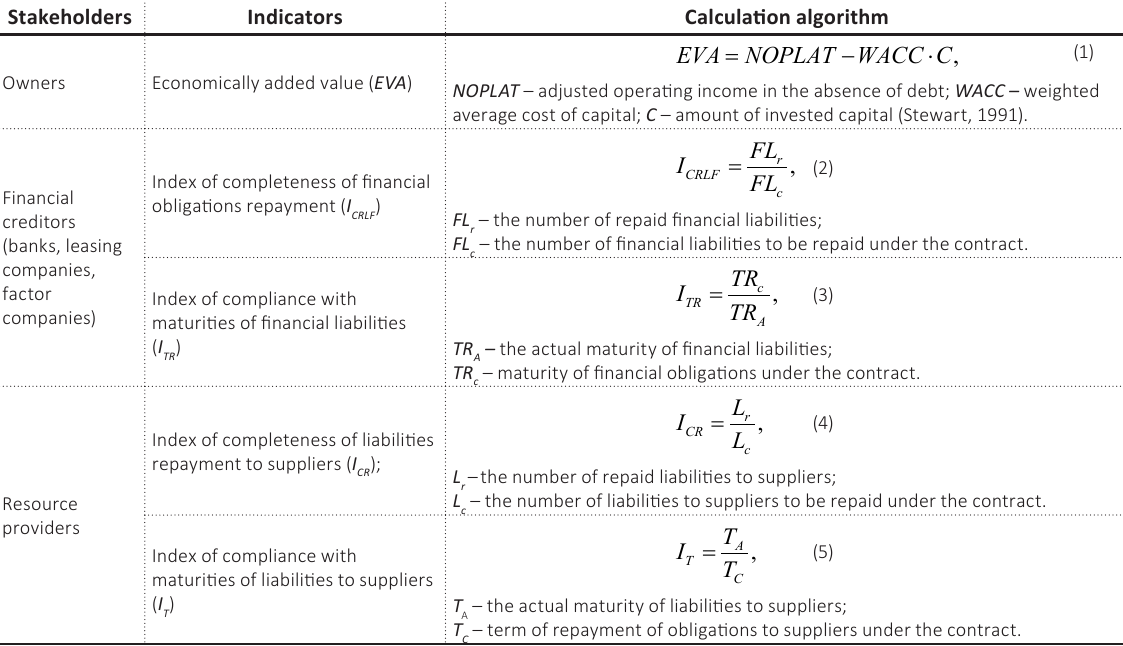
Table 2. Personalized performance indicators that reflect the financial interests of stakeholders